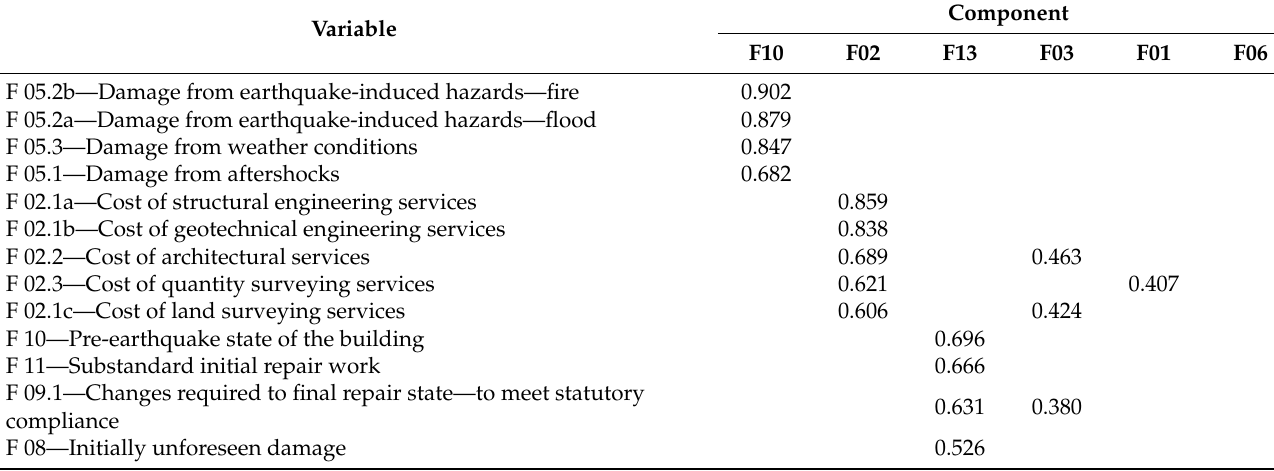
Table 8. Rotated component